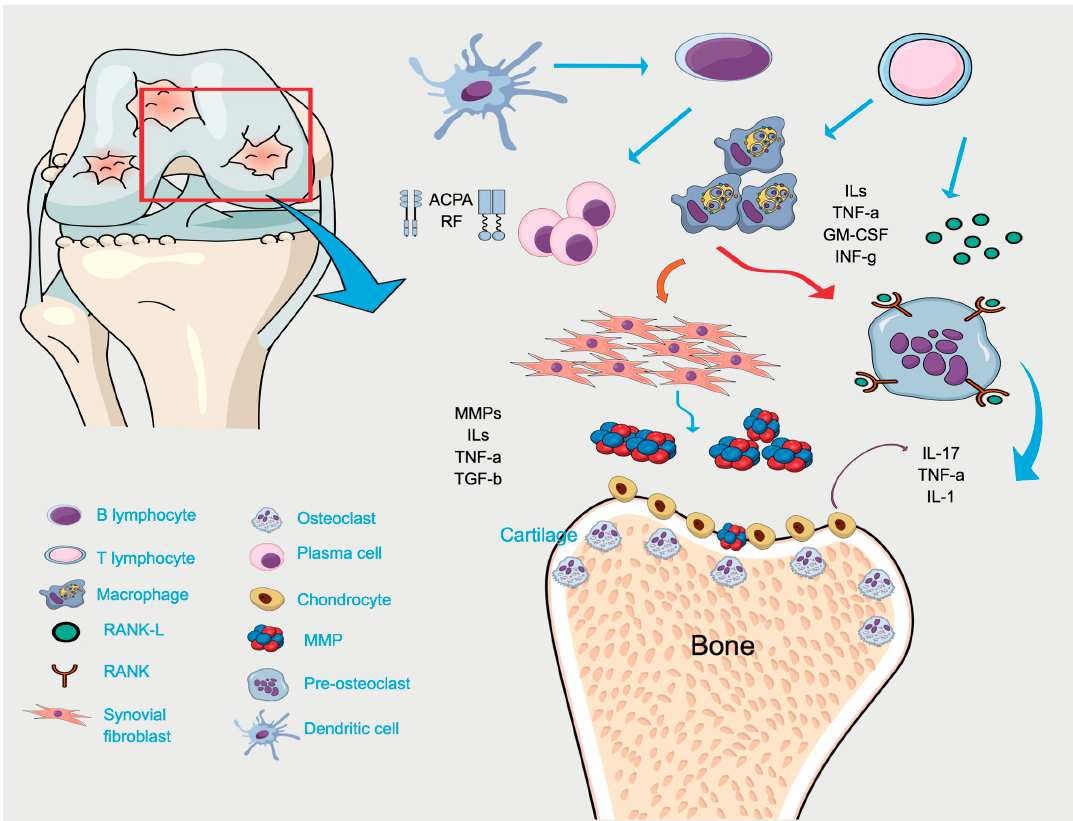
Figure 3. The pathogenesis of rheumatoid arthritis. The innate immune process is characterized by the infiltration of several inflammatory cells, chemokines, as well as other inflammatory mediators into the joint. Rheumatoid factor (RF) and anti-citrullinated proteins antibodies (ACPAs), the two most important autoantibodies, are typically produced by plasma cells. The coordinated production of proinflammatory cytokines and chemokines play crucial role in the orchestration of the inflammatory responses that ultimately result in the cartilage and bone destruction. Macrophages, synovial fibroblast, and dendritic cells produce several pro-inflammatory mediators such as Interleukins (IL-1, IL-2, IL-6, IL-10, IL-13, IL-15, IL-17, IL-18, Tumor Necrosis Factor- α (TNF- α ), Granulocyte macrophage colony-stimulating factor (GM-CSF), and metalloproteinases (MMPs). In addition, the T cells activation leads to overproduction of inflammatory cytokines, including TNF-a, IL-1b, and IL-6 by macrophages. The overexpression of inflammatory cytokines enhances the capacity to induce the production of RANKL, which is the main regulator of osteoclastogenesis. These cells of the innate immune system hold extensive proinflammatory, destructive, and remodeling capacities, and substantially contribute to inflammation and joint destruction in RA.